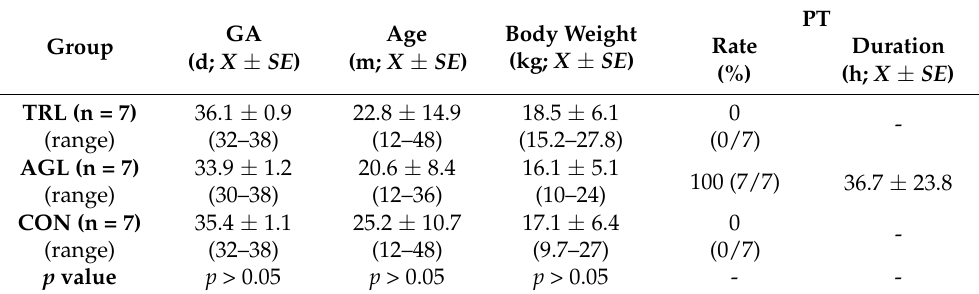
Table 2. Mean gestational age, age, body weight, PT rate, and average PT duration of the dogs in the study